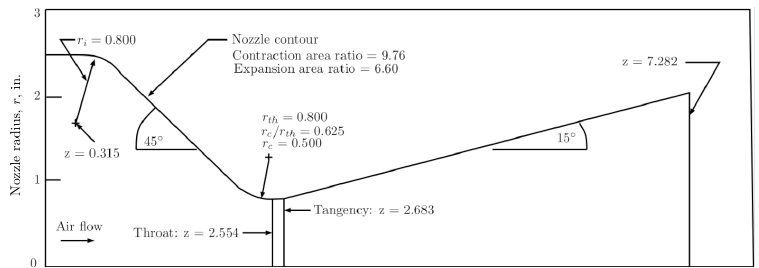
Figure 5. Jet Propulsion Laboratory (JPL) nozzle